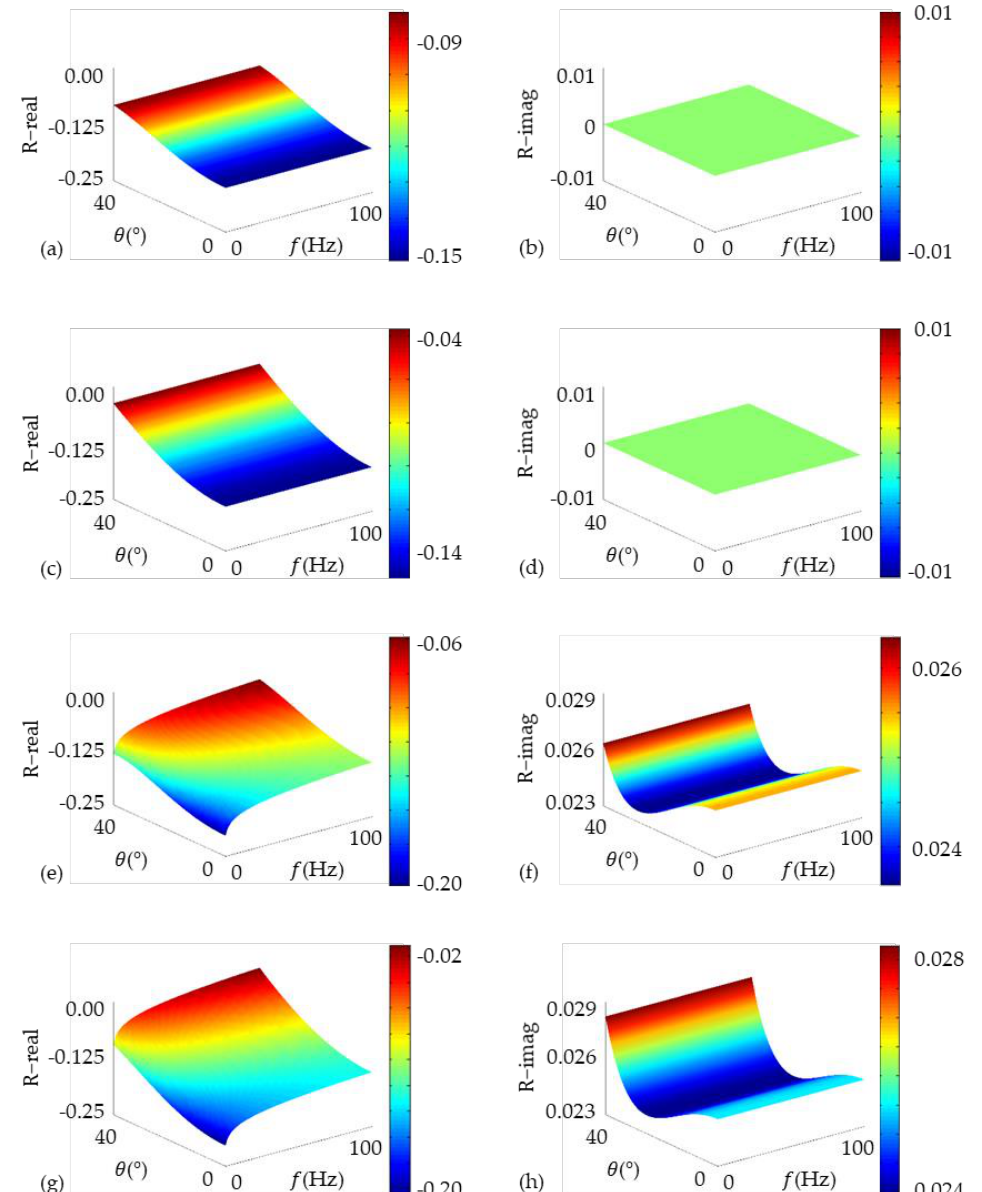
Figure 2. The variation of reflection coefficient with the incident angle θ and frequency f for model 1. ( a , b ), ( c , d ), ( e , f ) and ( g , h ) show the real part and imaginary part of reflection coefficients in four cases of assumption: (1) elastic isotropy, (2) elastic anisotropy, (3) attenuated isotropy, and (4) attenuated anisotropy separately. Different reflection coefficient values represent in corresponding colorbars.